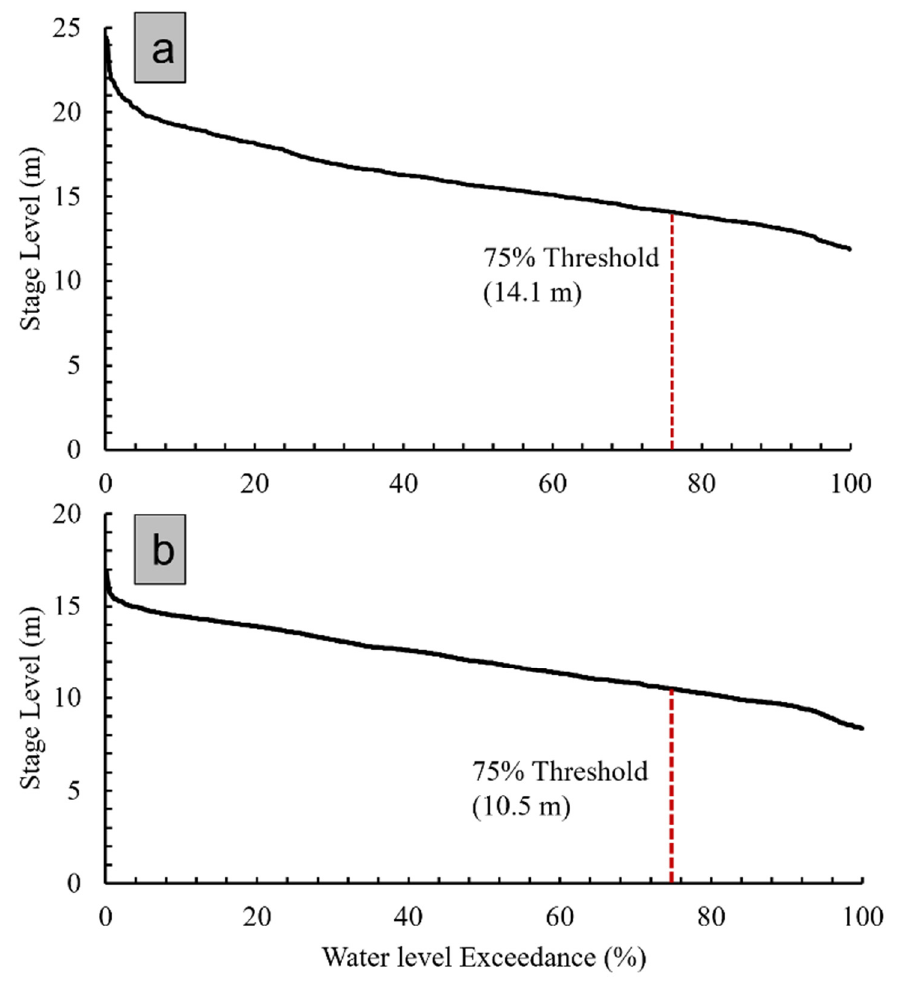
Figure 6. Water level exceedance probabilities for the Chattahoochee ( a ) and Blountstown ( b ) stations.